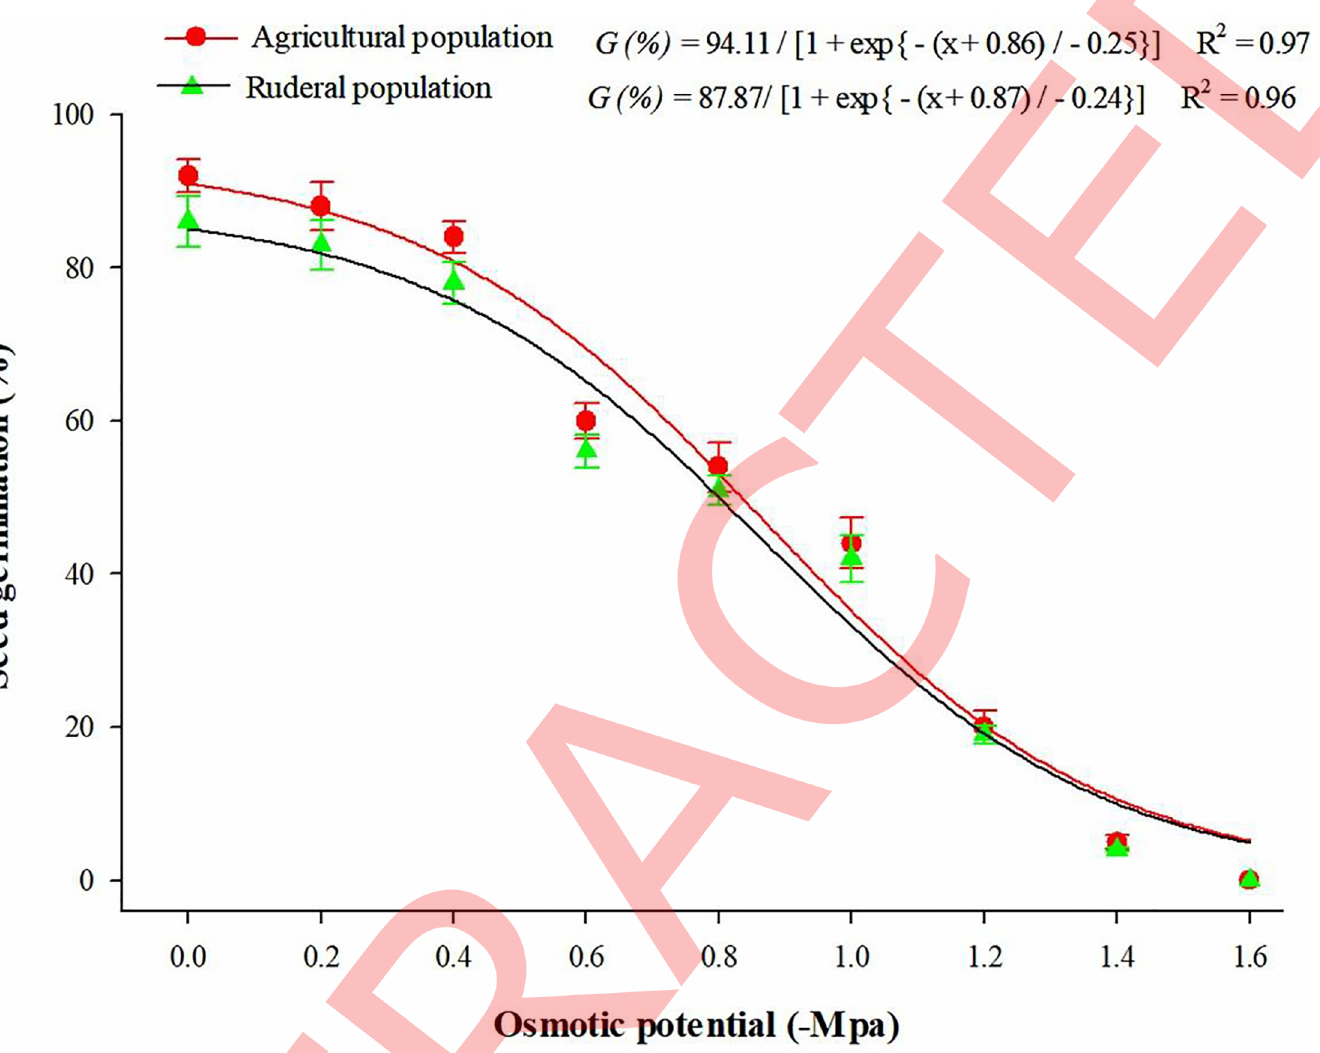
Fig 5. The influence of different osmotic potentials on seed germination percentage of ruderal and agricultural populations of Xanthium strumarium L.